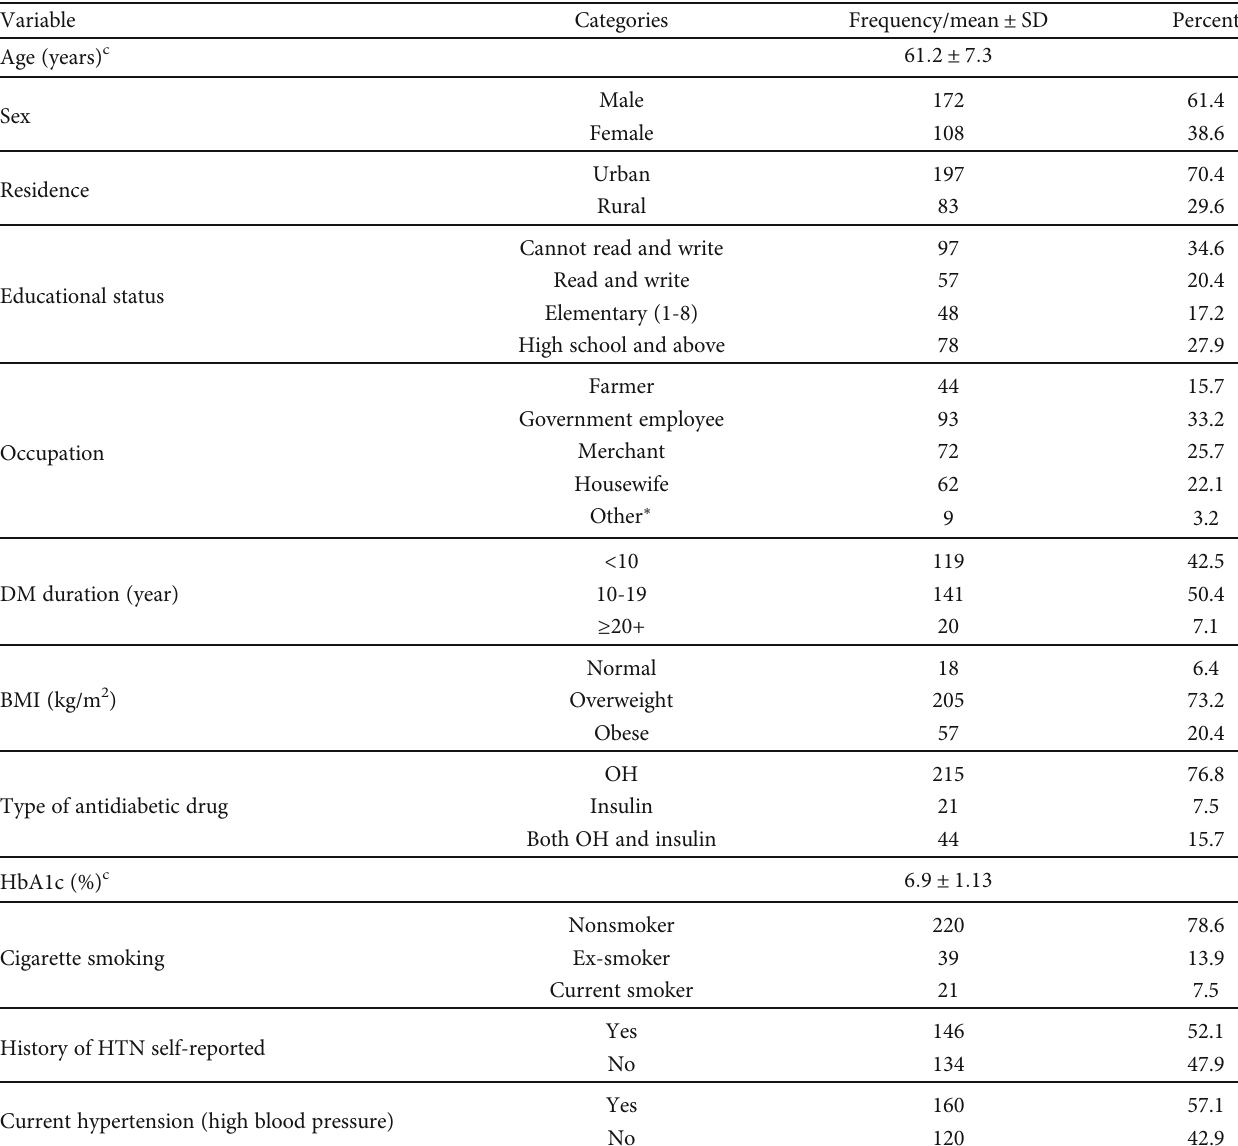
Table 1: Sociodemographic and clinical characteristics of T2DM patients, Debre Tabor, Northwest Ethiopia, 2019. Variable